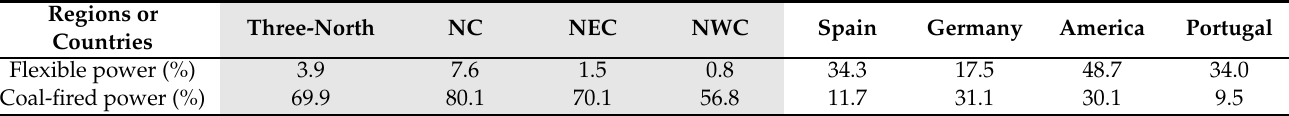
Table 1. Flexible and coal-fired power in power supply structure,